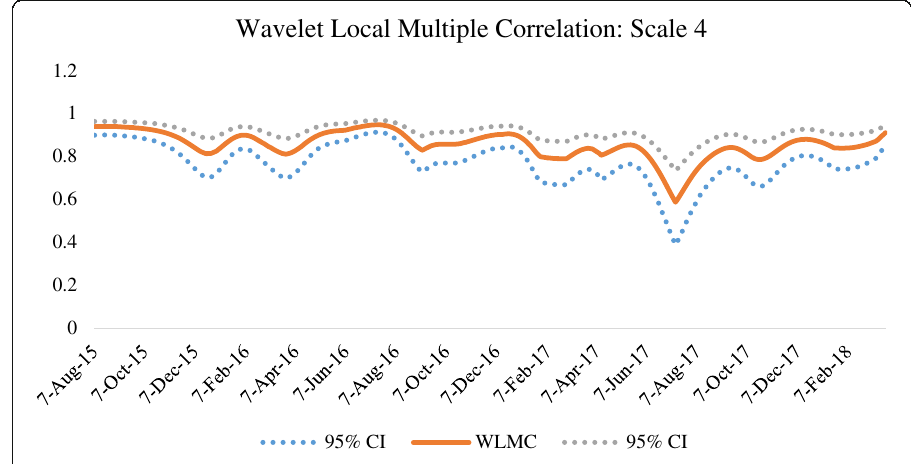
Fig. 7 Wavelet Local Multiple Correlation for Scale 4 (16 – 32 day time period)